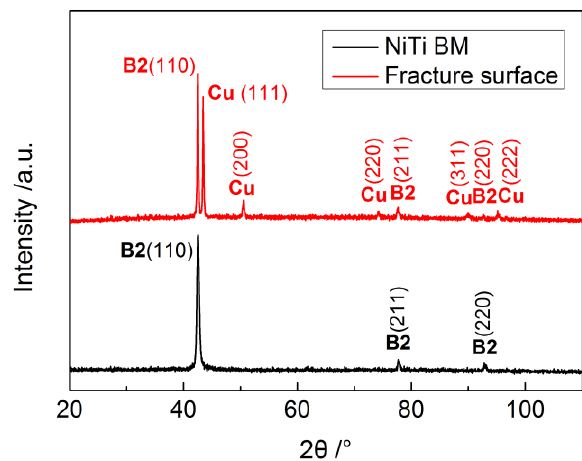
Figure 8. XRD patterns of NiTi BM and fracture surface of 1000 J weld.